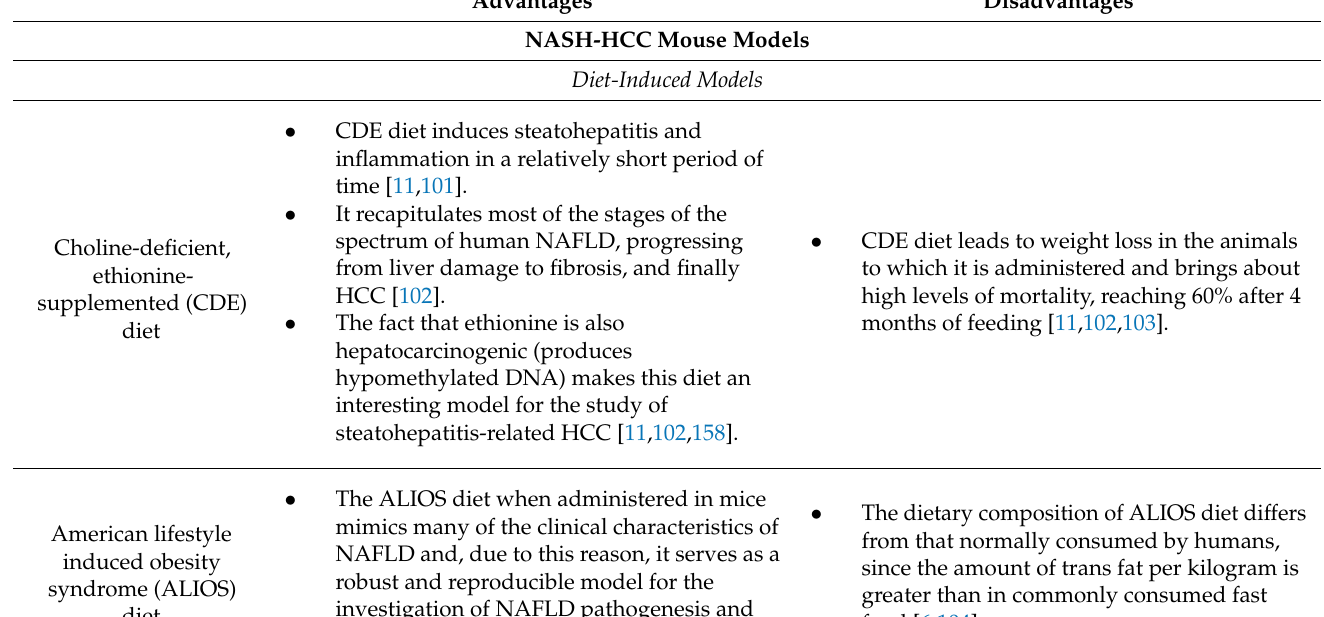
Table 1. Cont . Advantages Disadvantages NASH-HCC Mouse Models Diet-Induced